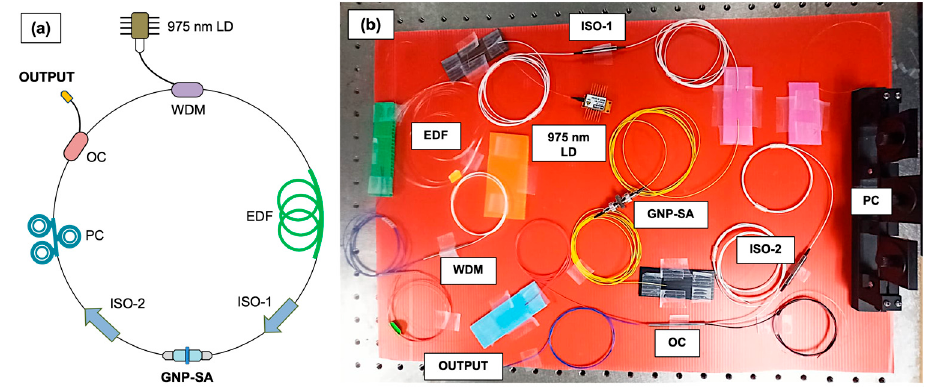
Figure 6. Experimental setup of mode-locked EDFL with GNP-SA ( a ) schematic diagram and ( b ) actual layout.